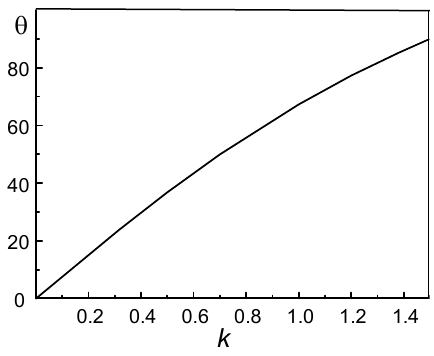
Figure A5. The curves of θ with respect to k .